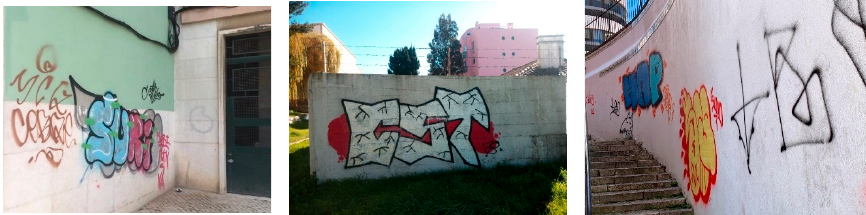
Figure 6. Dataset samples of images with illegal graffiti.